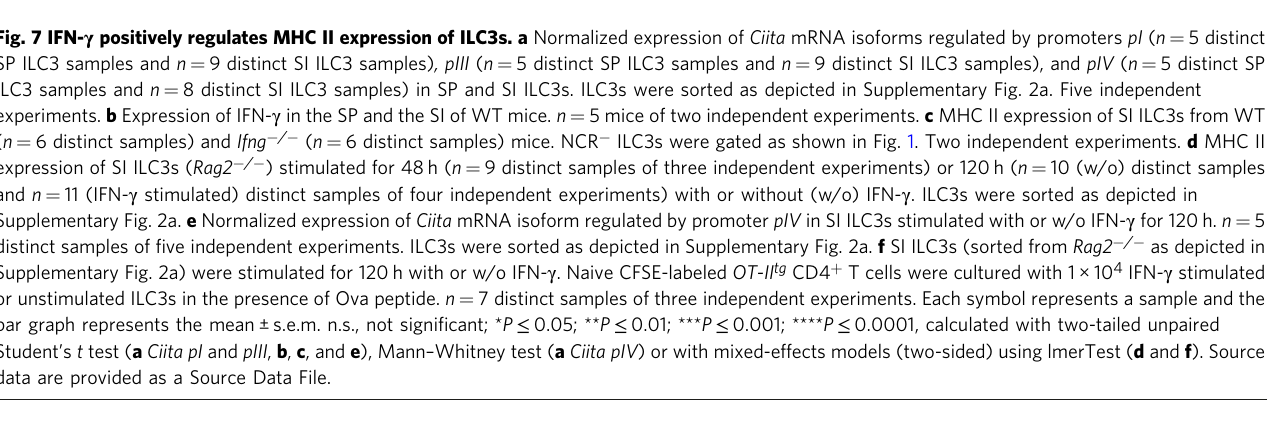
Fig. 7 IFN- γ positively regulates MHC II expression of ILC3s. a Normalized expression of Ciita mRNA isoforms regulated by promoters pI ( n = 5 distinct SP ILC3 samples and n = 9 distinct SI ILC3 samples) , pIII ( n = 5 distinct SP ILC3 samples and n = 9 distinct SI ILC3 samples), and pIV ( n = 5 distinct SP ILC3 samples and n = 8 distinct SI ILC3 samples) in SP and SI ILC3s. ILC3s were sorted as depicted in Supplementary Fig. 2a. Five